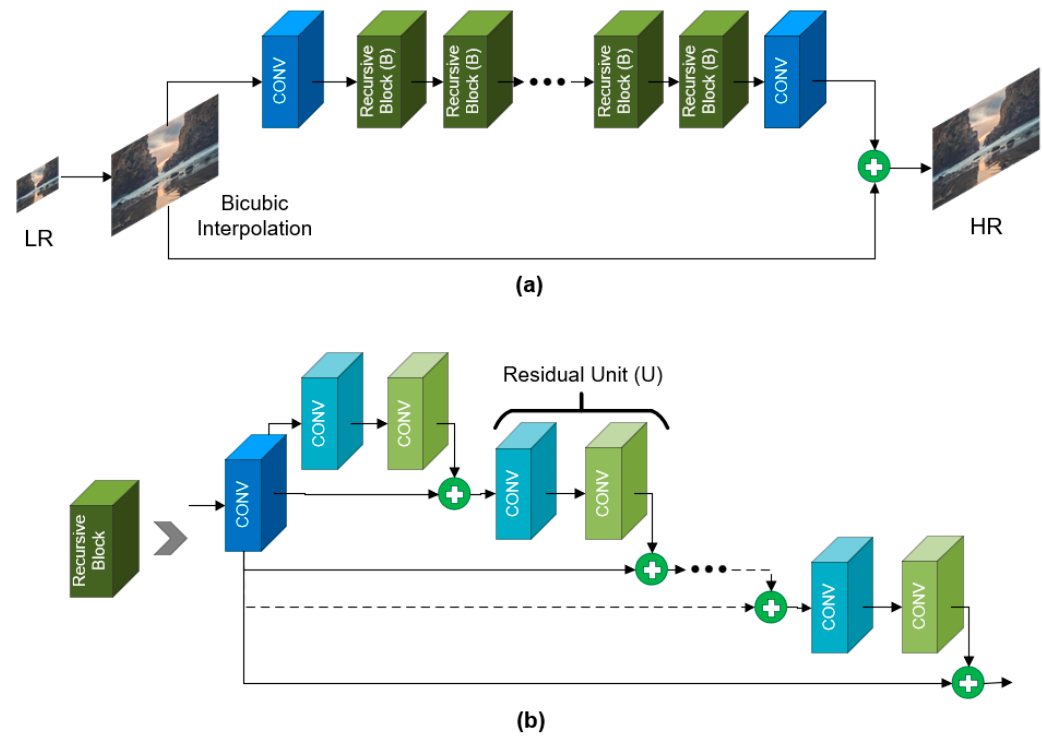
Figure 11. ( a ) DRRN network structure; ( b ) Network structure of recursive block in DRRN.